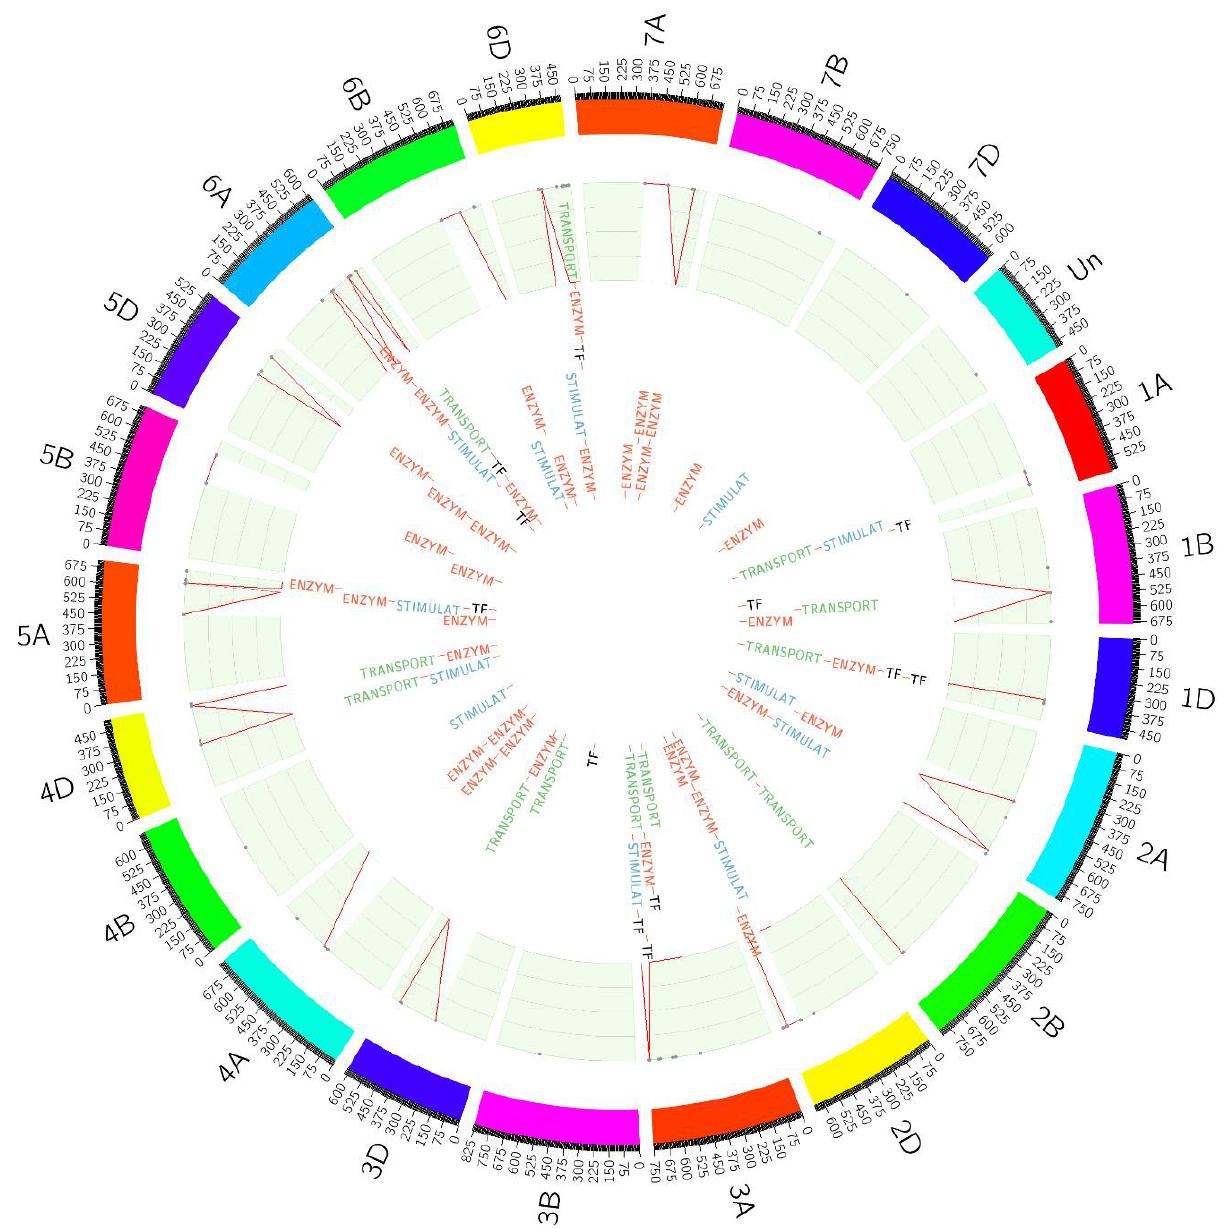
Figure 9. Chromosome wise SSR-containing unigenes distribution over 21 chromosomes of wheat by the circular plot. The context inside of the circus is the names of the primers’ category in the SSR-containing unigenes. The red lines are represented the polymorphic primers that were discovered in